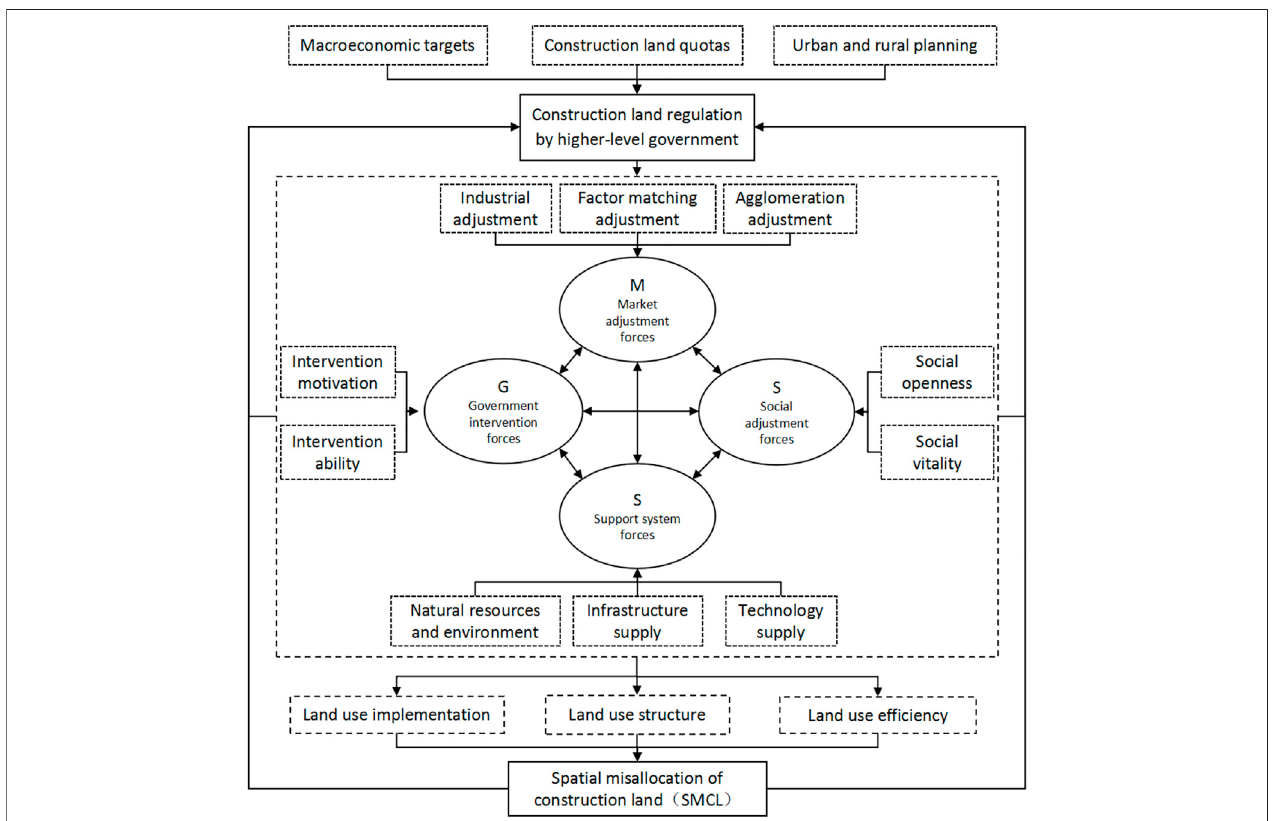
FIGURE 1 | GMSS analytical framework for the in fl uencing factors of the